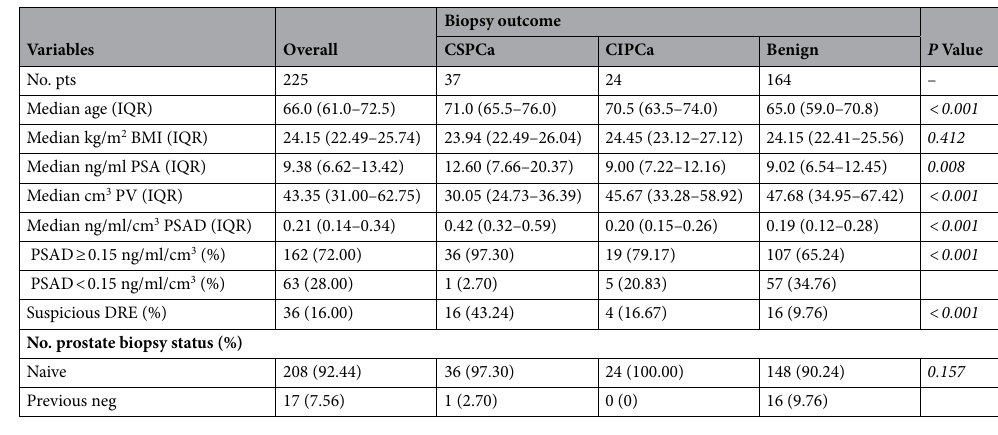
Table 1. Demographic data of patients with negative MRI who underwent PB. IQR Interquartile range, BMI Body Mass Index, PSA prostate specific antigen, PV prostate volume on MRI, PSAD PSA density, DRE digital rectal examination, CSPCa clinically significant prostate cancer, CIPCa clinically insignificant prostate